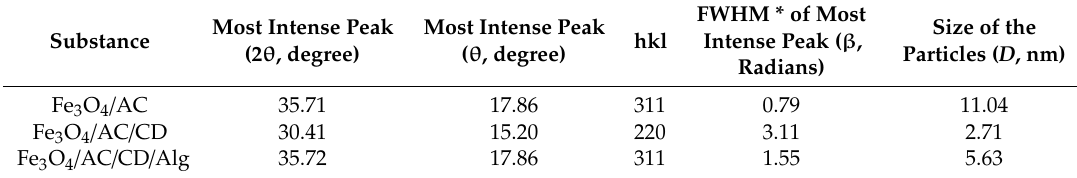
Table 1. Crystallite size values calculated using the Debye–Scherrer